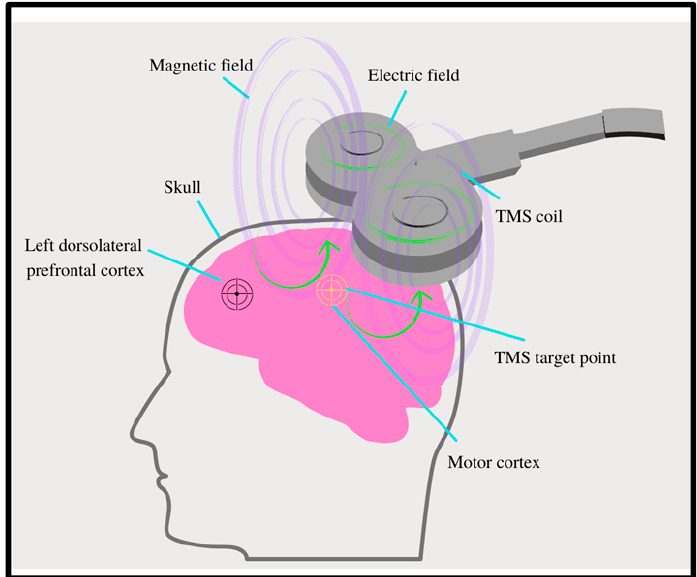
Figure 1. Components of repetitive magnetic transcranial stimulation (rTMS): rTMS is a non-invasive therapy that utilizes a wire coil connected to a magnetic stimulator. The electromagnetic current generated by the coil is applied to the scalp of patients directed at the area of interest, modulating neuronal excitability. The dorsolateral prefrontal cortex (DLPFC) is a common target of rTMS utilization in tinnitus.